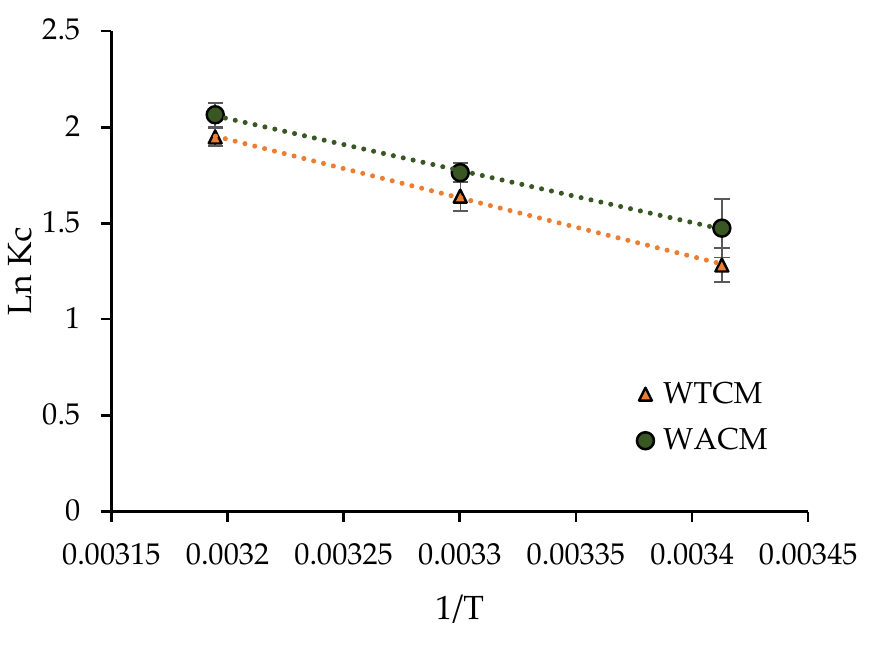
Figure 11. lnK c vs. 1/T plot for Pb(II) biosorption onto WTCM and WACM at pH = 4, biosorbent Table 5. Thermodynamic parameters for Pb(II) adsorption on WACM and WTCM.